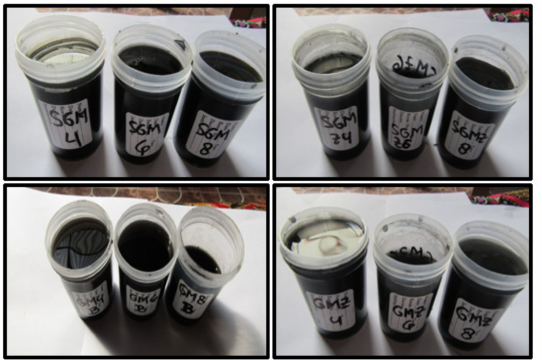
Figure 7. Concentrated colloid of CNS (code without Z) and ZnS/CNS (code with Z) which were prepared from pyrolysis of sawdust (SG) and rice husk